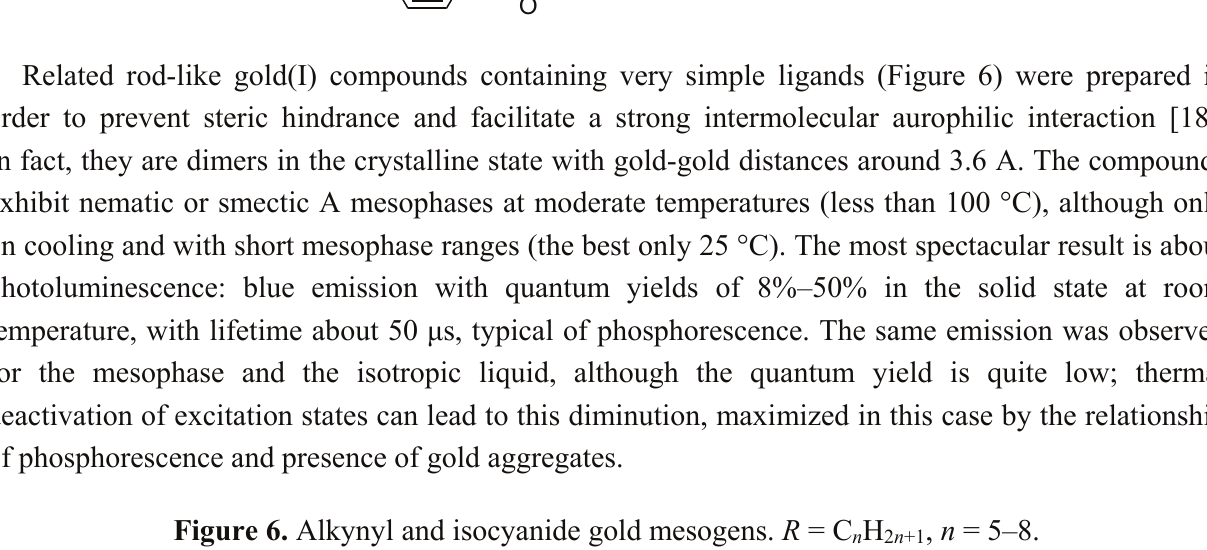
Figure 6. Alkynyl and isocyanide gold mesogens. R = C